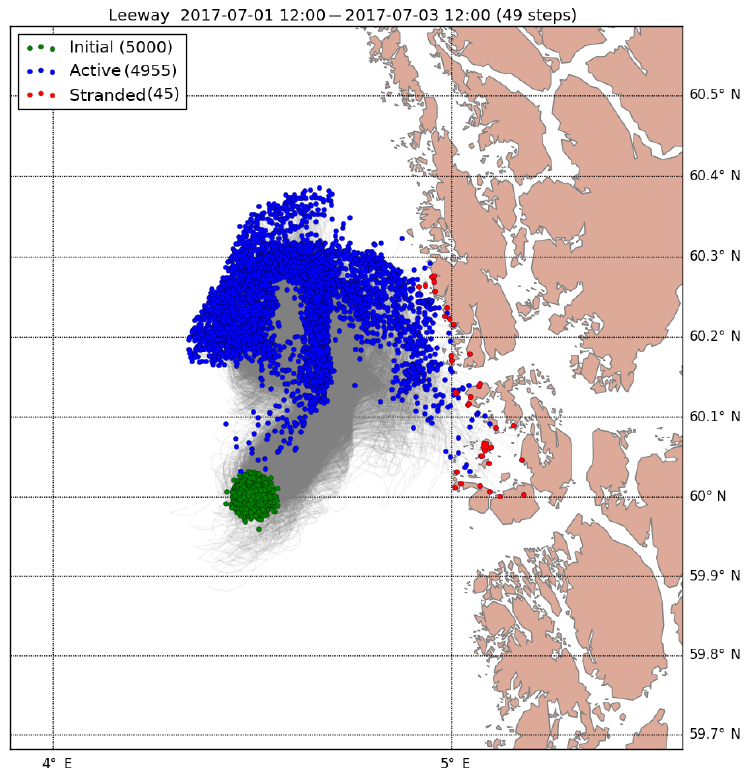
Figure 2. Output from the Leeway example of Sect. 3.1. Green dots are the initial positions of the elements (life rafts), grey lines are trajectories, and blue dots are positions at the end of the simulation. Red dots indicate elements which have hit land